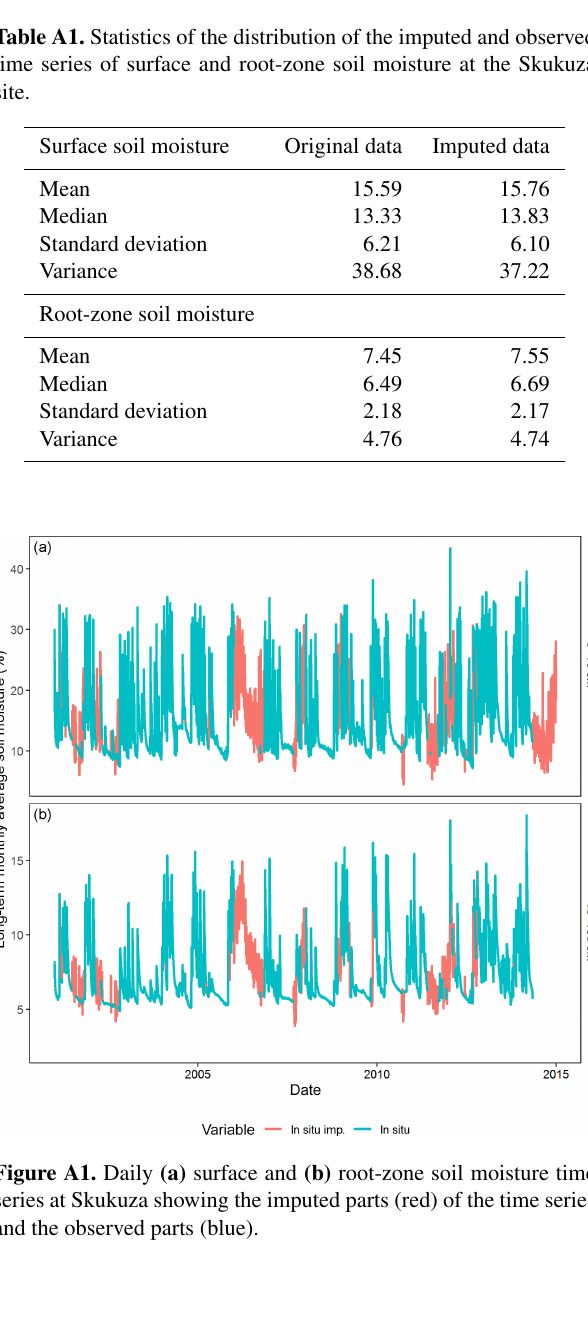
Table A1. Statistics of the distribution of the imputed and observed